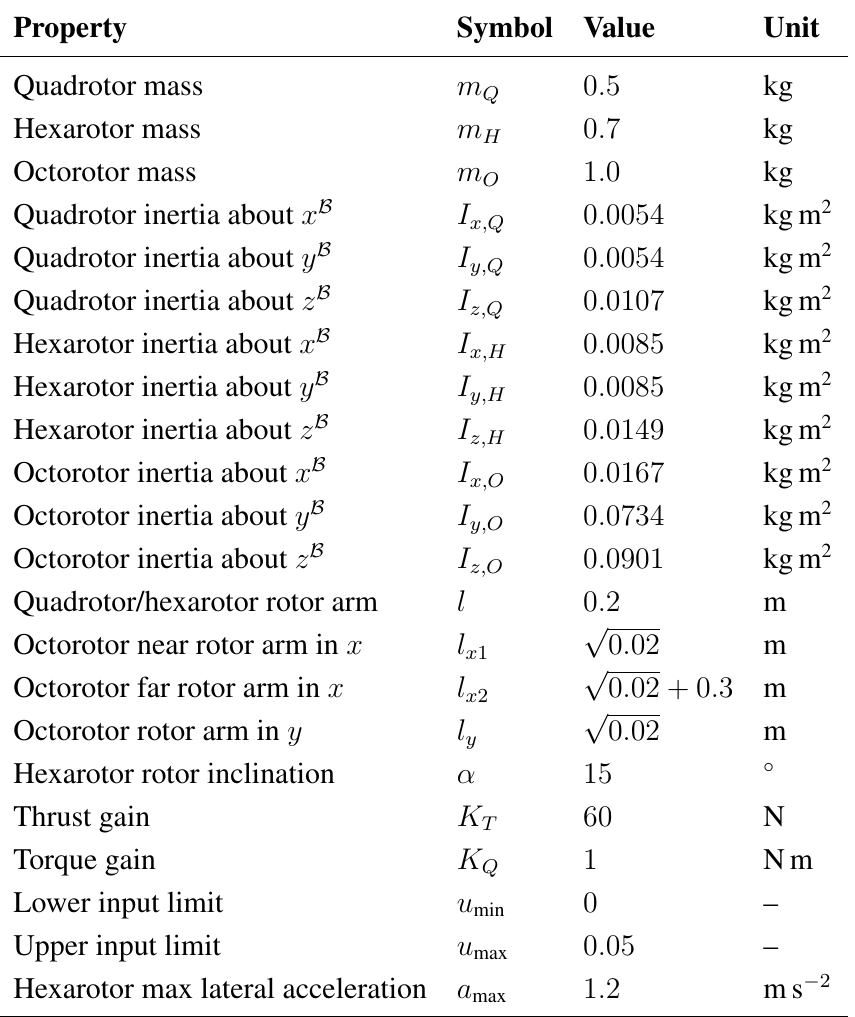
Table 1. Multirotor properties for simulation